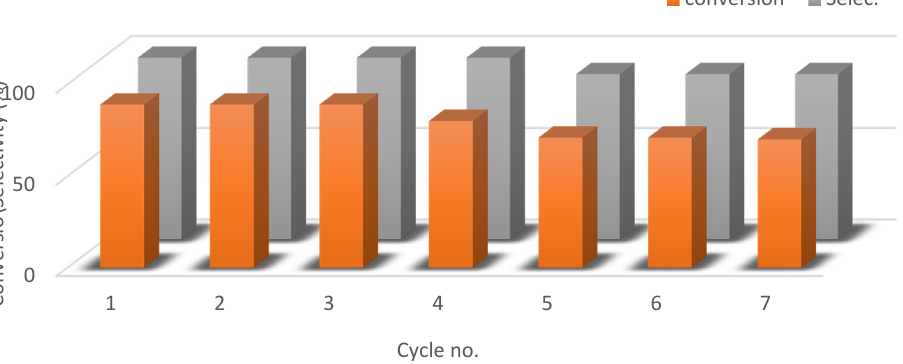
Figure 14. Recyclability test of the NiFe 2 O 4 -NP catalyst. The weight loss of catalyst after four runs was 25 wt.%.